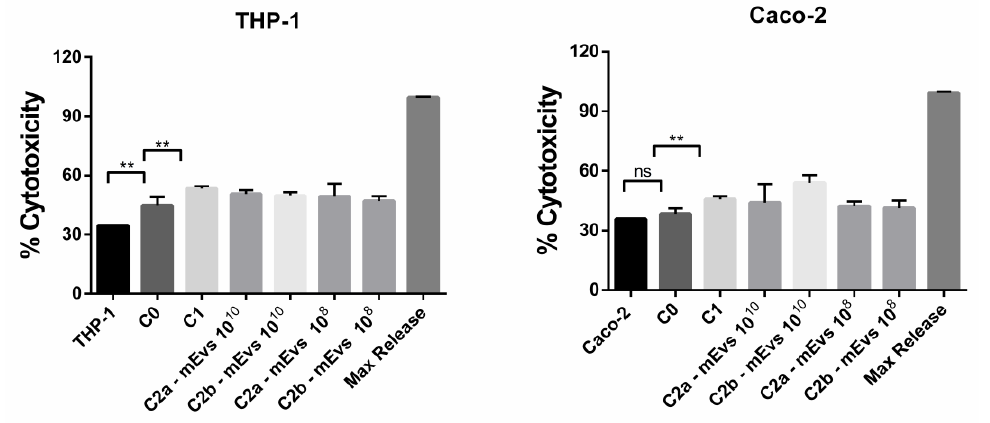
Figure 4. The lactate dehydrogenase (LDH) assay in the presence of mEVs. LDH release from Caco-2 or THP-1 in the presence or absence of two different concentrations of mEVs. LDH was measured by optical density measurement at 490 nm in the supernatant recovered after 24 h mEV treatment. Caco-2 and THP-1 alone were used as a positive control, C0 co-culture before inflammation, C1 co-culture after 24 h of inflammation, C2a mEV administration to Caco-2 cells in the AP compartment of 24 h inflamed co-culture, C2b mEV administration to Caco-2 and THP-1 cells in the AP compartment and BL compartment respectively of mEVs after 24 h inflamed co-culture. The figure reports data from the triplicate experiment analyzed by a one-way ANOVA test, with mean ± SD values. ** p < 0.01 and ns p >